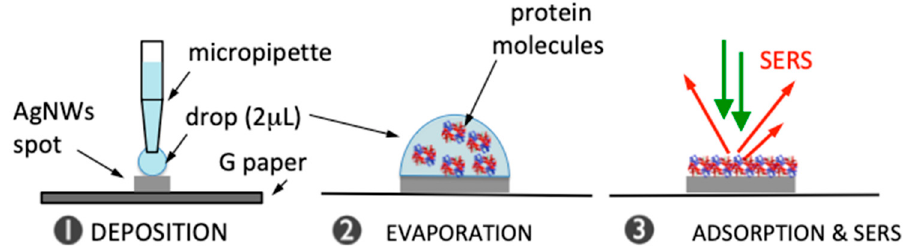
Figure 3. Working scheme of AgNWs@G-paper substrates: a small (2 μ L) drop of protein solution is deposited on a AgNWs spot and confined due to the surrounding graphene hydrophobic barrier. After drop drying (~15 min at room temperature), the drop content is physically adsorbed on the surface of AgNWs and exposed to an effective E-field generating intense SERS signals.